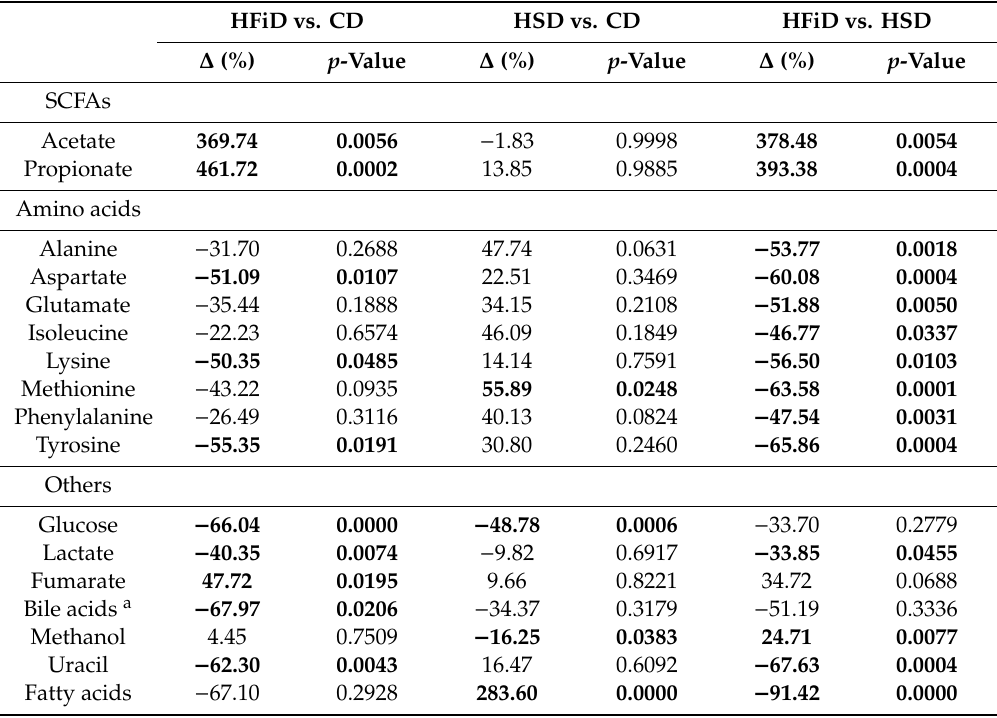
Table 1. Significant diet-induced changes in fecal metabolites